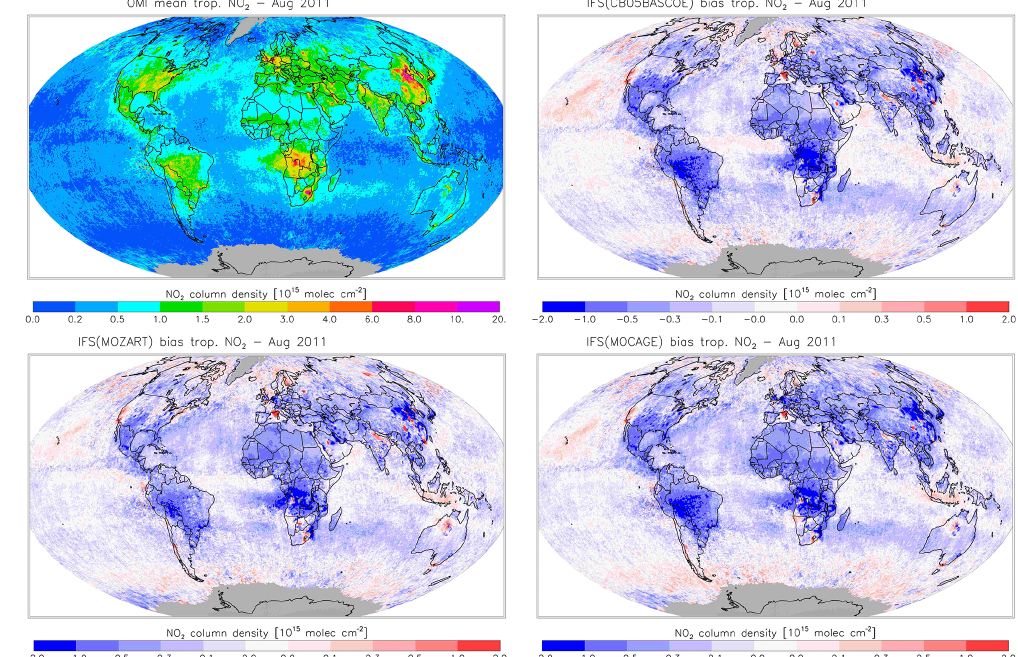
Figure 19. Monthly mean tropospheric NO 2 columns from OMI satellite retrievals from the QA4ECV product for August 2011, along with the corresponding collocated model